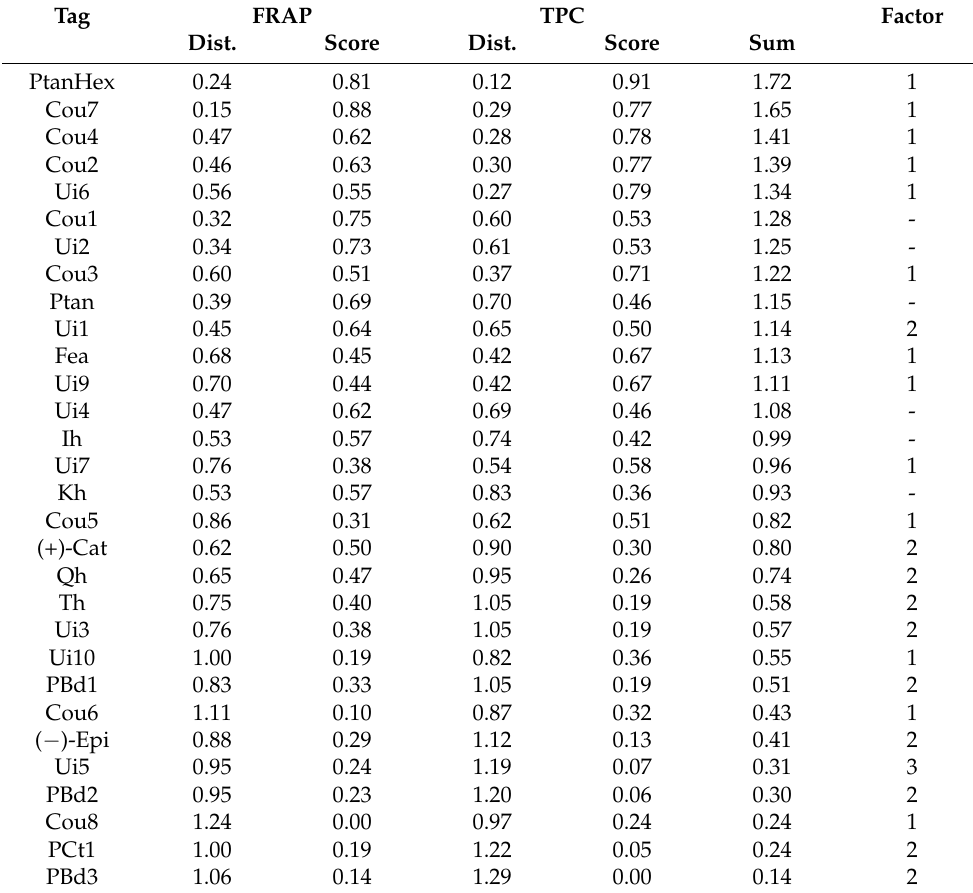
Table 3. Factor analysis of the polyphenol peak areas and the antioxidant properties of Norway spruce cone extracts. “Factor” indicates the factor that correlates best with the given concentration of a given compound; “Dist.” is the Euclidian distance of a given compound from the FRAP or the TPC vector. FRAP: Ferric Reducing Antioxidant Power; TPC: Total Polyphenol Content. For the interpretation of the tags please refer to Table